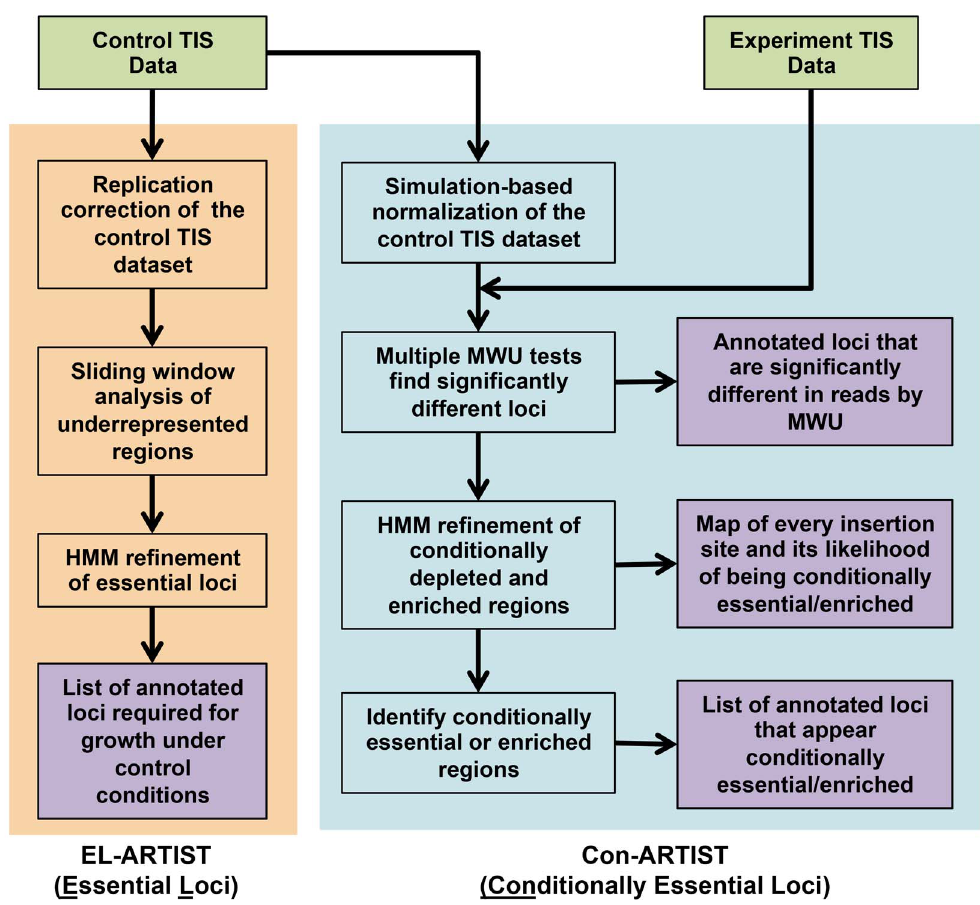
Figure 1. Flowchart of the ARTIST pipeline. Mapped reads from the control and experimental TIS libraries are tallied into read counts for every transposon insertion (see the Text S1 for example data formats). In the essential loci analysis arm, EL-ARTIST (shaded in orange), the control TIS data is first normalized to remove replication bias [34] and then a sliding window method [35] is used to initially define stretches of insertions that appear underrepresented in the data. These regions are subsequently used to train a hidden Markov model (HMM), which will refine the grouping of adjacent insertions into essential regions across the entire genome. The steps in this arm have been previously published [9]. In the conditionally essential analysis arm, Con-ARTIST (shaded in blue), the control dataset is first subjected to simulation-based normalization to compensate for genetic drift and sampling error. The resulting simulated control datasets are then compared to the experimental dataset using Mann-Whitney U (MWU) rank sum tests. Genes that are significantly different in reads with high reproducibility can be defined at this step. Alternatively, significantly under- and overrepresented genes from the MWU can serve as a training set for a HMM to further classify all genomic sites of insertion as conditionally depleted, enriched or unchanged between growth conditions. These assignments can be subsequently combined and used to categorize annotated genomic loci. Experimental data that is provided by the user are shown in green, while outputs from the ARTIST pipeline are shaded in purple.